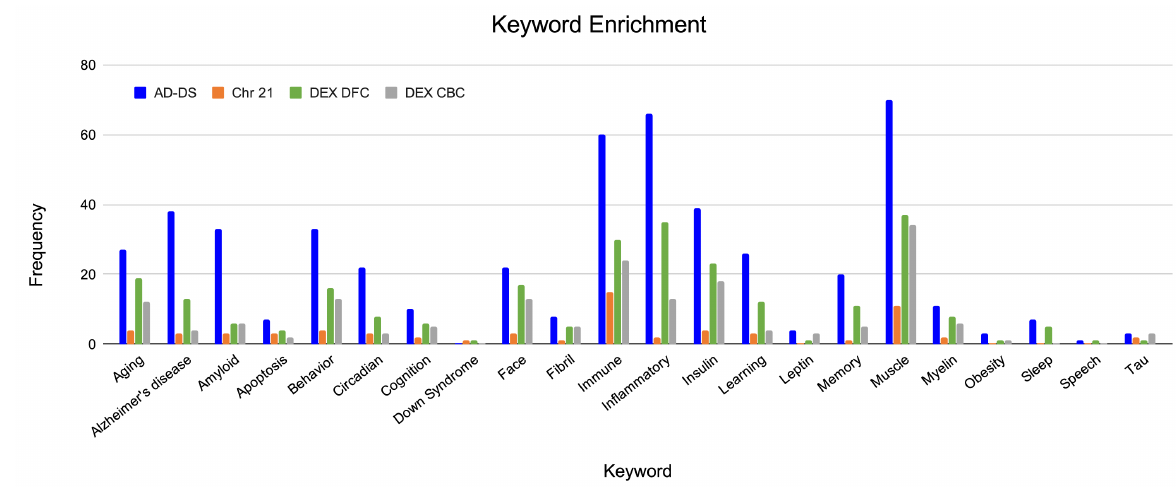
Figure 2. Keyword enrichment. Identification of genes associated with terms relating to AD and DS based on gene ontology term classification. AD-DS genes: blue, Chr 21 genes: orange, DEX DFC genes: green, DEX CBC genes: gray, X-axis, keyword categories; Y-axis, frequency of occurrence in the